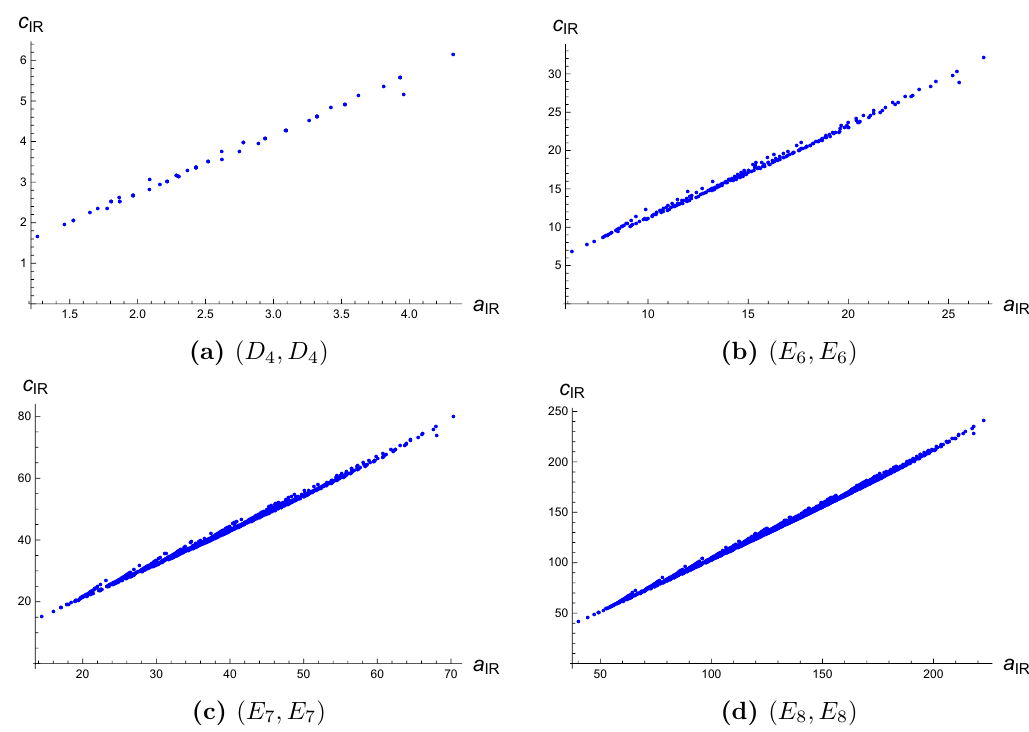
Figure 11. Plots of c IR vs. a IR for (cid:13)ipper (cid:12)eld deformations of 4D conformal